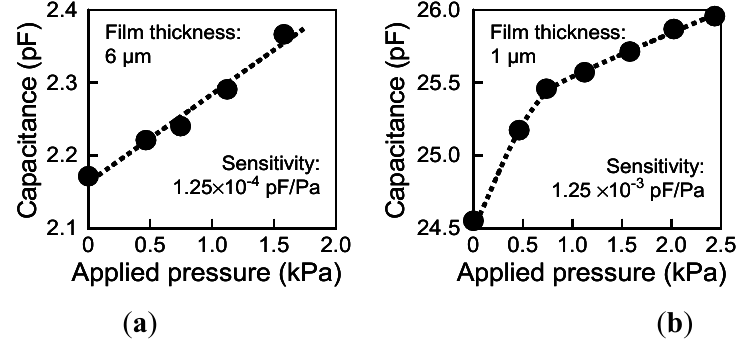
Figure 11. Capacitance of fabricated tactile sensor versus applied pressure when film thickness is ( a ) 6 µm and ( b ) 1